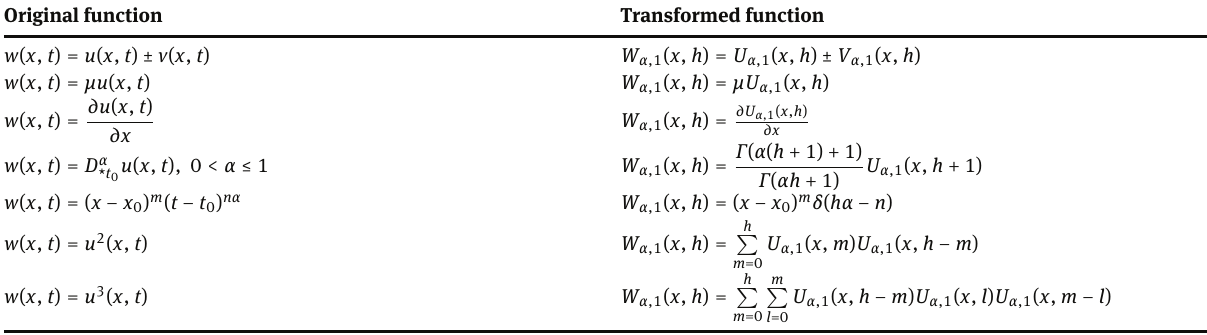
Table 2: The operations for the two-dimensional MFDTM. Original function Transformed